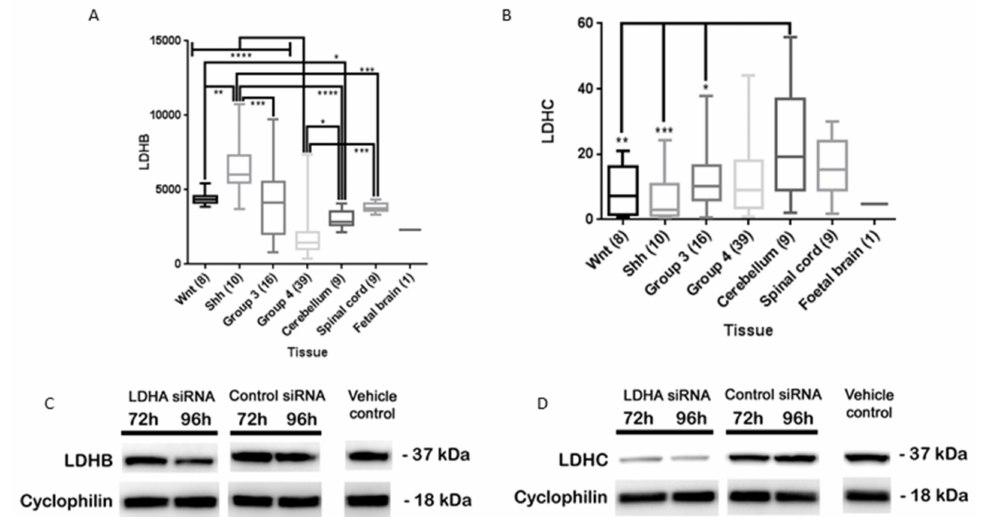
Figure 5. Effects of LDHA siRNA on UW402 LDHB and LDHC expression. ( A , B ) Expression of ( A ) LDHB and ( B ) LDHC in MB subgroups, non-neoplastic cerebellum, spinal cord and foetal brain. The number of samples per tissue is stated in brackets. Graphs show box plots (highest value, lowest value, upper quartile, lower quartile, interquartile range and median). Not significant p > 0.05, * p ≤ 0.05, ** p ≤ 0.01, *** p ≤ 0.001, **** p ≤ 0.0001; ( C , D ) Western blots of lysates prepared